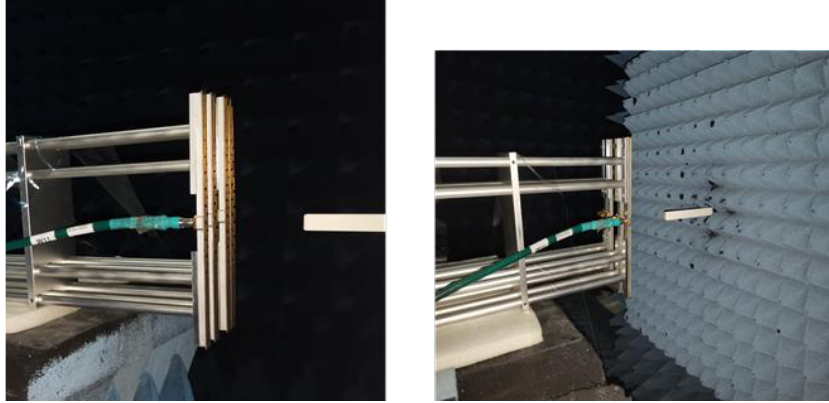
Figure 18. Measurement of fabricated one-dimensional sparse array in the anechoic chamber.